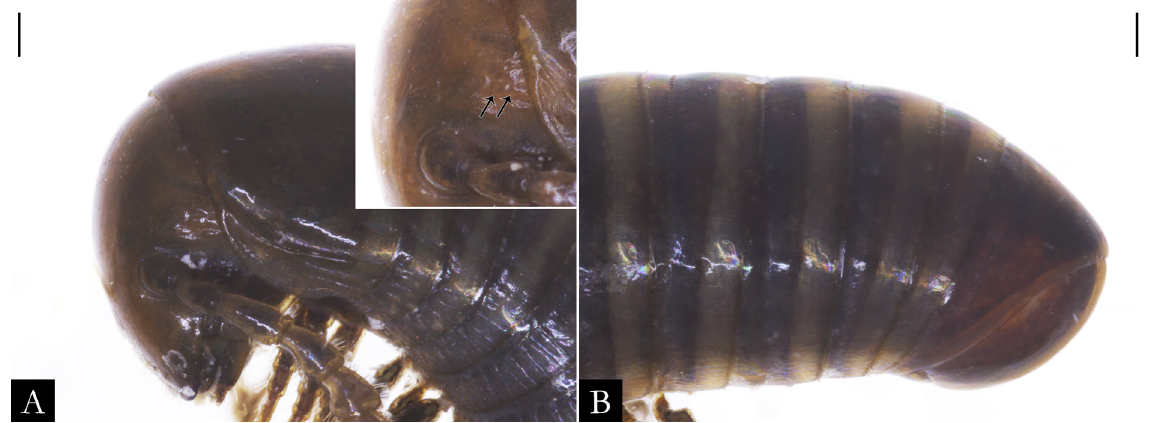
Fig. 81. Pseudonannolene leucomelas Schubart, 1947, paratype, ♀ (MNRJ 11829), in lateral view. A . Anterior region (arrows indicating the ommatidial cluster). B . Posterior region. Scale bars = 0.2 mm.